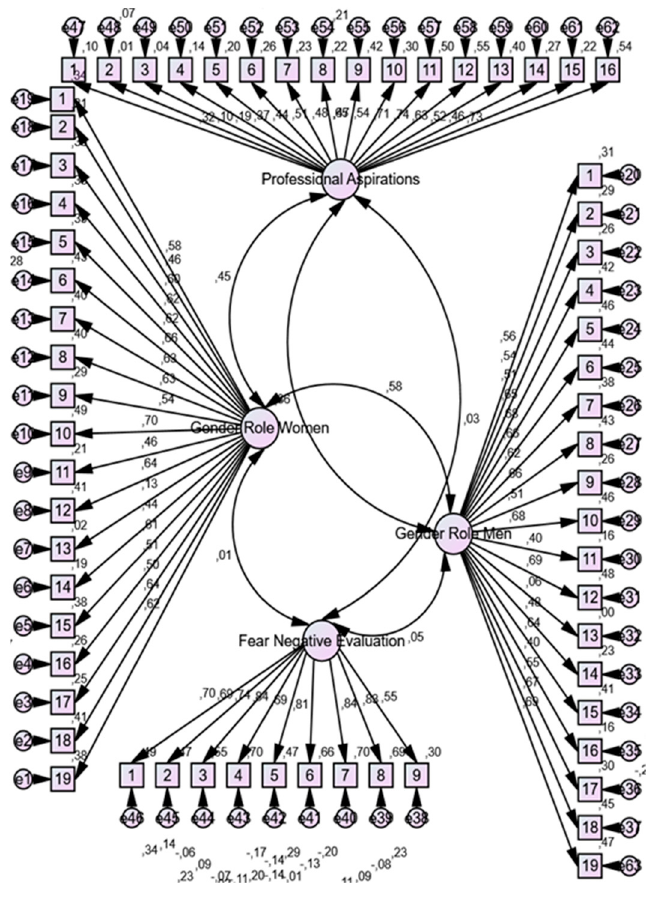
Figure 1. Four-factor model (CFA).